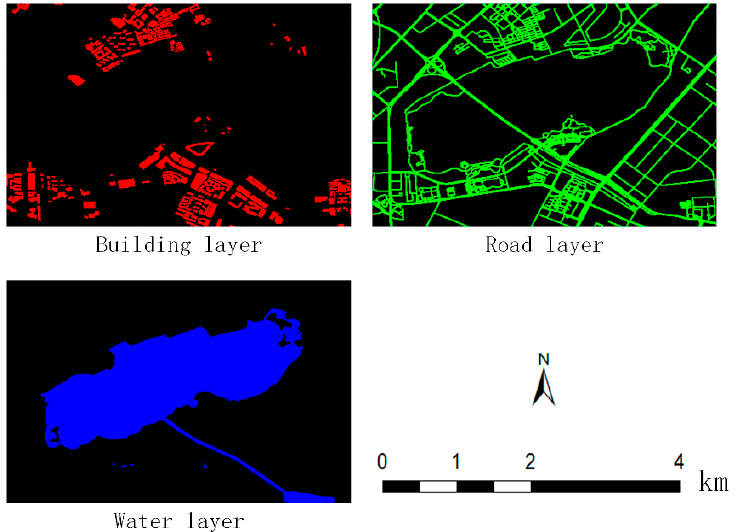
Figure 4. A sample of the OSM data.